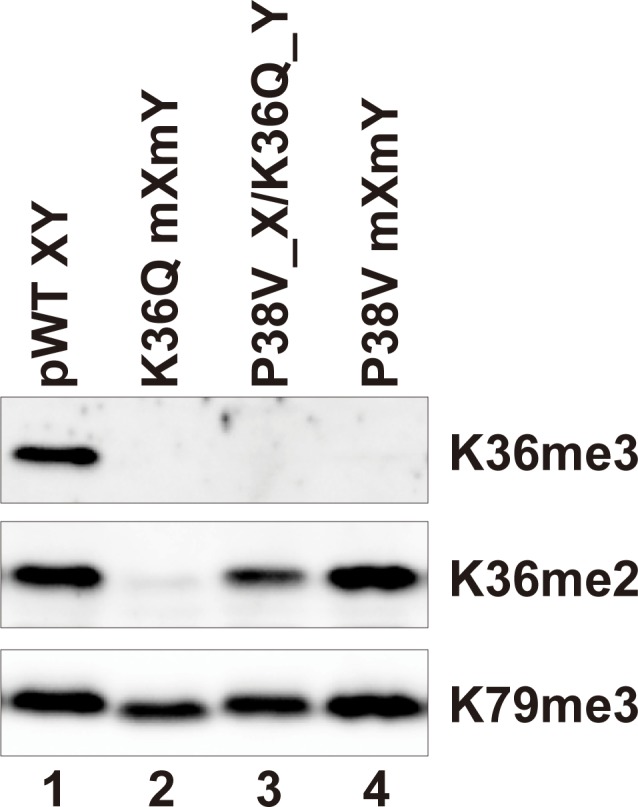
H3P38V mutations block trimethylation but not dimethylation of H3K36.Whole cell extracts of the indicated strains were separated by 15% SDS-PAGE and transferred to a membrane. The same blot was probed sequentially with the following antibodies: anti-H3K36me3 (Active Motif MABI0333), anti-H3K36me2 (Abcam ab9049) and anti-H3K79me3 (GeneTexRM157). Strains analyzed were: pWT XY (PKY4704), K36Q mXmY (PKY4834), P38V_X/K36Q_Y (PKY5140), P38V mXmY (PKY5037).